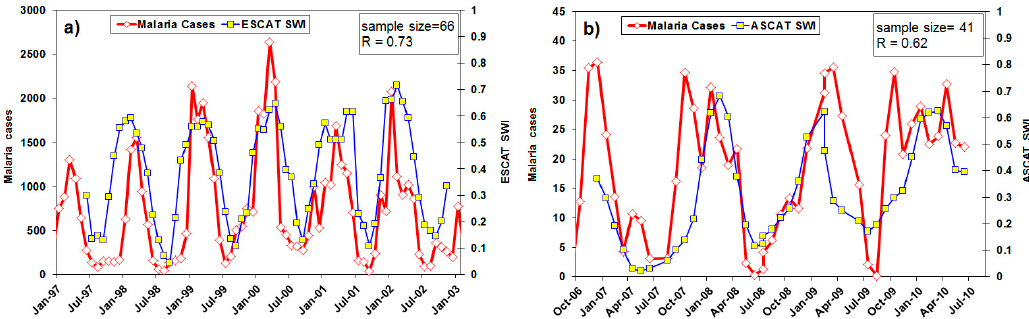
Figure 5. Comparison between malaria cases and soil moisture time series obtained by ESCAT Soil Water Index: SWI, in Mpumalanga ( a ); and ASCAT SWI in Botswana ( b ). The data on malaria cases are obtained by: Montosi et al. [132] ( a ); and by Chirebvu et al. [131] ( b ). R is the Pearson’s correlation coefficient.